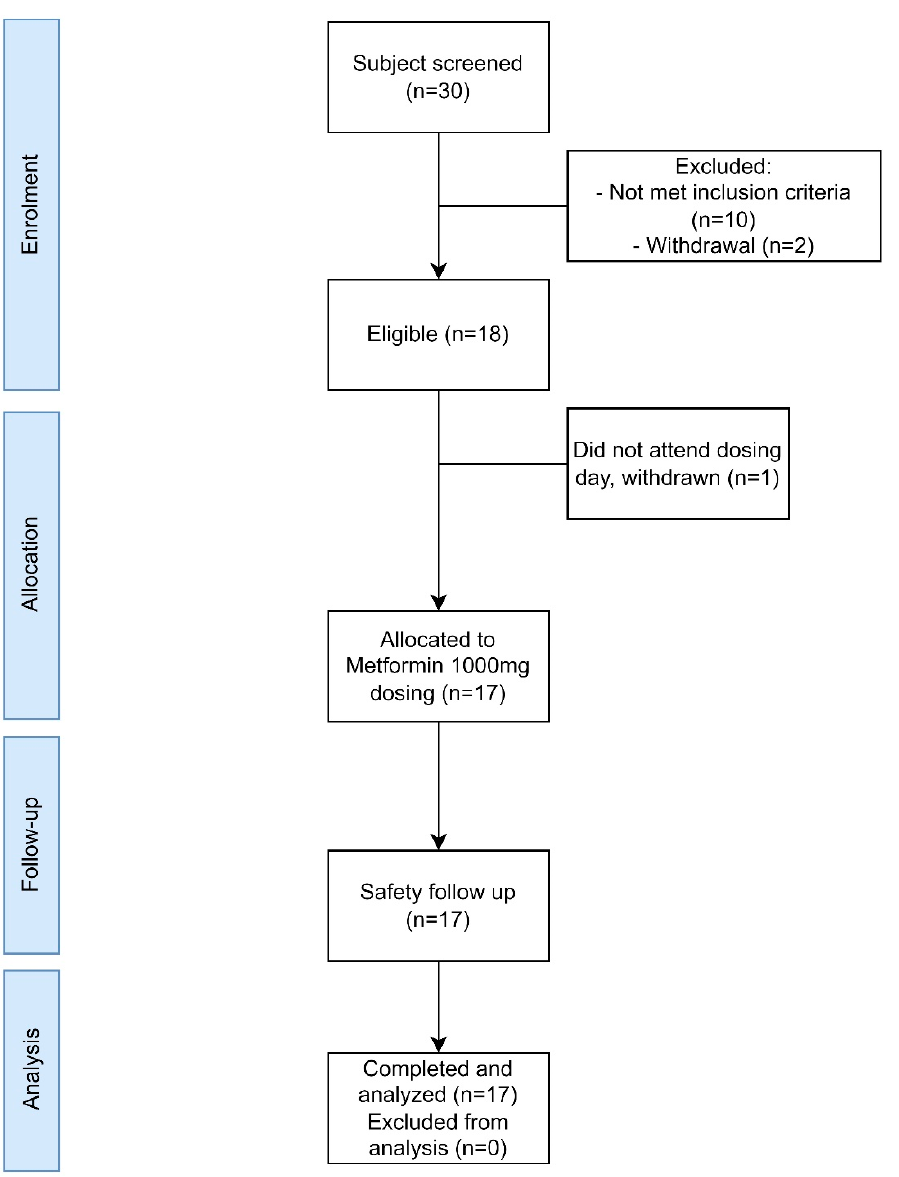
Figure 2. Subject disposition flow chart. Table 1. Demographic and clinical characteristics of the study population.